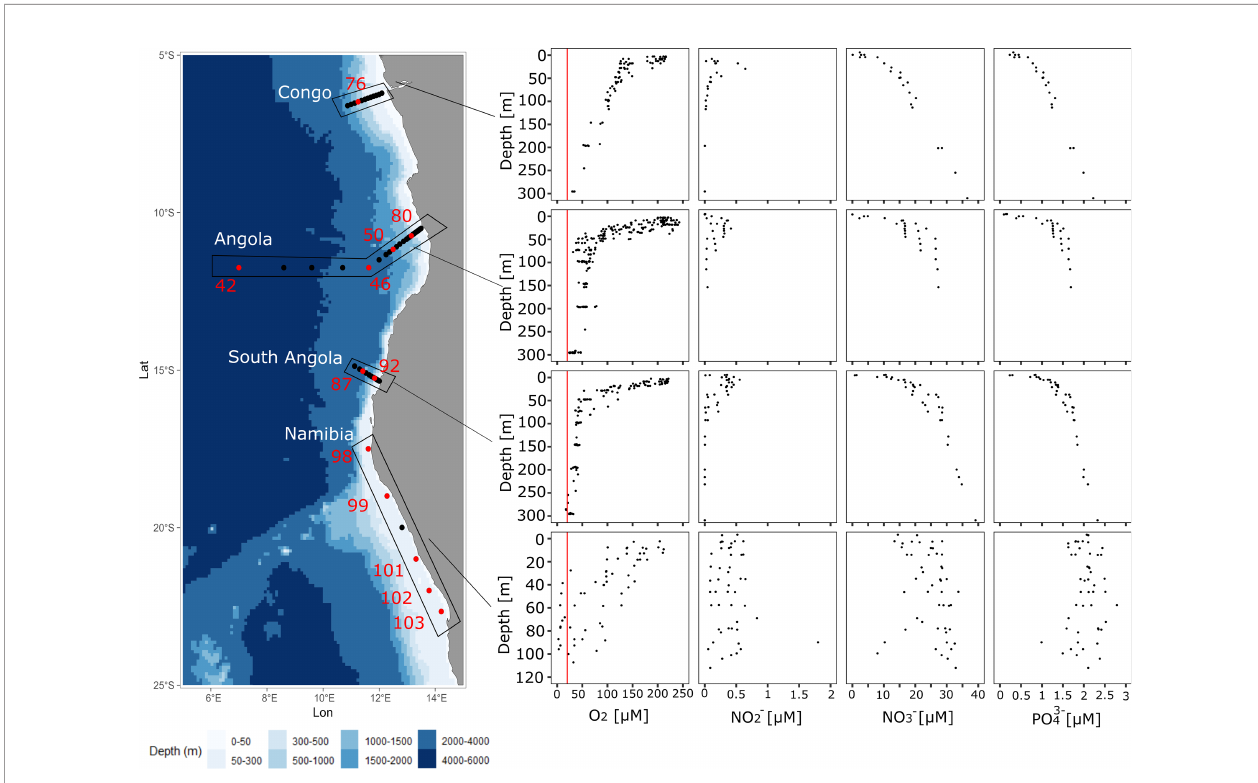
FIGURE 1 | Left panel: Topographical map of the North ATZ (north of 10°S) and South ATZ (between 10 and 15°S) and the North BUS (15-25°S). The four coastal sections of the cruise track are indicated with black dots. Red dots indicate stations from which nifH amplicons were generated. Right panels: Oxygen and nutrient depth pro fi les from each transect as indicated with black boxes on the map. The red line indicates an O 2 concentration of 20